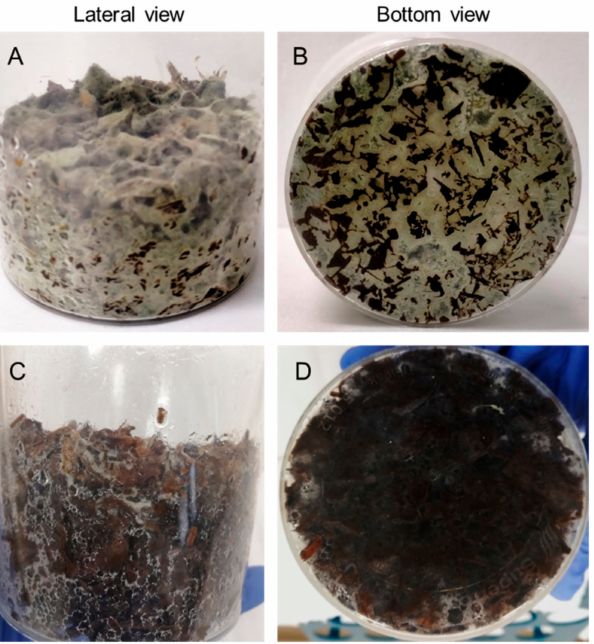
Figure 2. Details of T. atroviride Ta13 ( A , B ) and T. reesei RUT-C30 ( C , D ) growth on substrate SSF2 after 6 days of